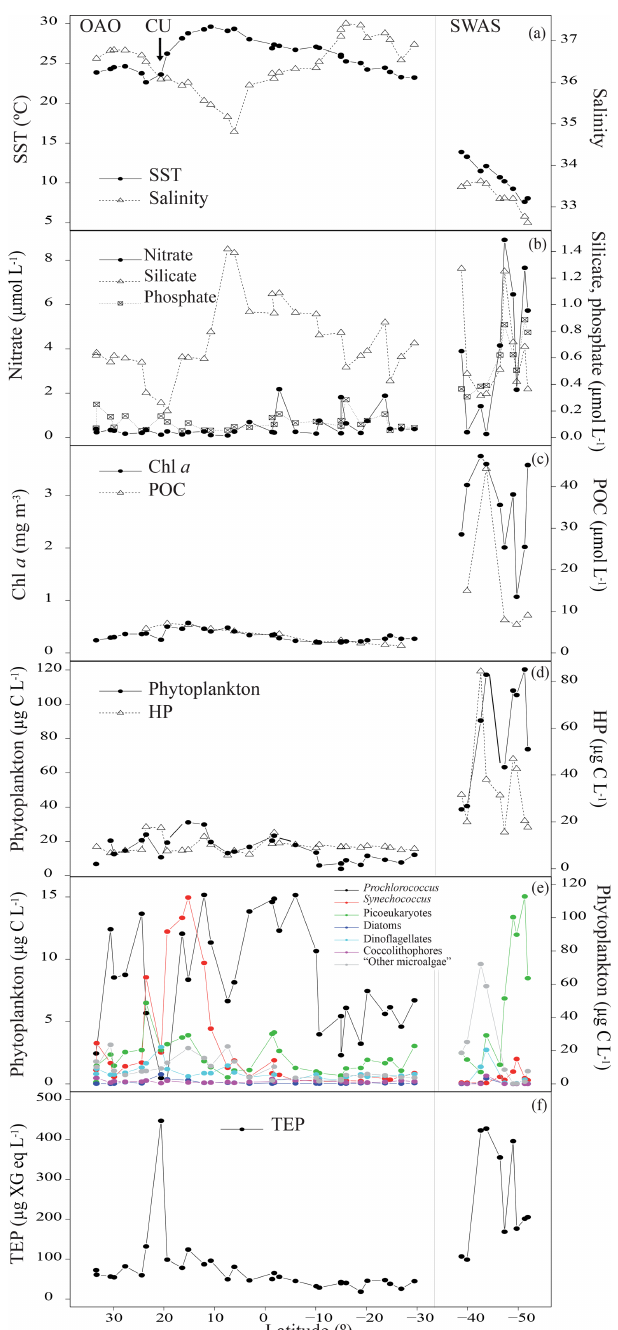
Figure 2. Variations of sea surface temperature (SST, ◦ C) and salinity (a) ; nitrate, silicate and phosphate (µmolL − 1 ) (b) ; Chl a (mgm − 3 ) and POC (µmolL − 1 ) (c) ; biomass of phytoplankton and HP (µgCL − 1 ) (d) ; biomass of Prochlorococcus , Synechococ- cus , picoeukaryotes, diatoms, dinoflagellates, coccolithophores and “other microalgae” (µgCL − 1 ). OAO (left axis) and SWAS (right axis) (e) and TEPs (µgXGeqL − 1 ) (f) in the TransPEGASO cruise.